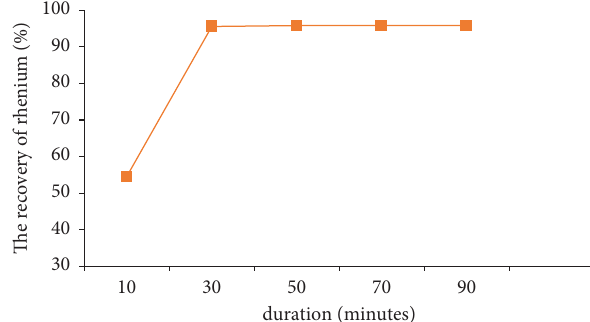
Figure 4: Infuence of the duration of the leaching process on the degree of extraction of rhenium ( S : L � 1: 3, temperature: 70 ° C, and stirring speed: